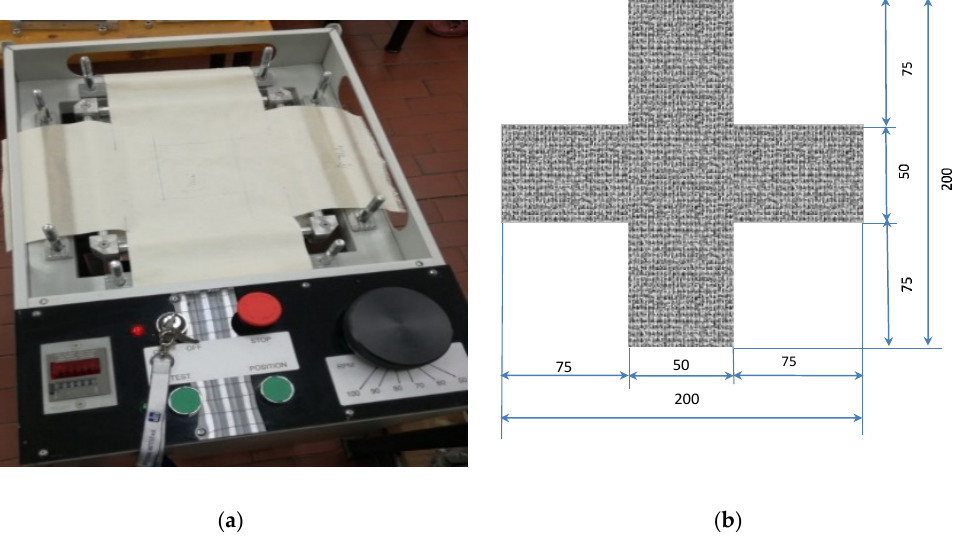
Figure 1. ( a ) Innovative cyclic biaxial stress measuring device, patent: HR P20150735; ( b ) sample